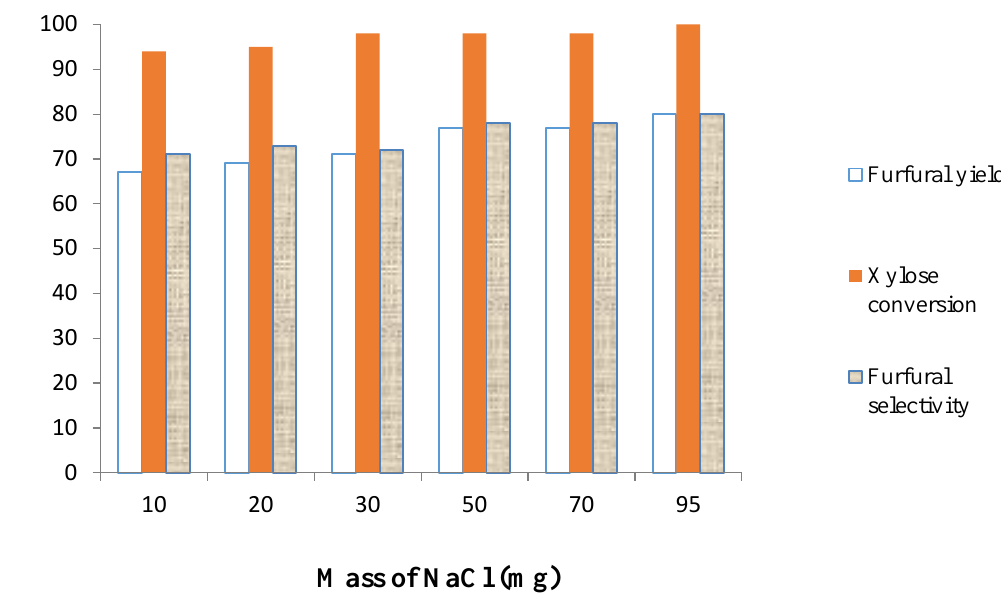
Figure 4. Effect of the amount of NaCl on the dehydration of D -xylose to furfural. Reaction conditions: Nafion NR50 (2 pellets), NaCl, D -xylose (1.0 mmol), water (1 mL), CPME (3 mL), MW, 170 °C and 40 min.